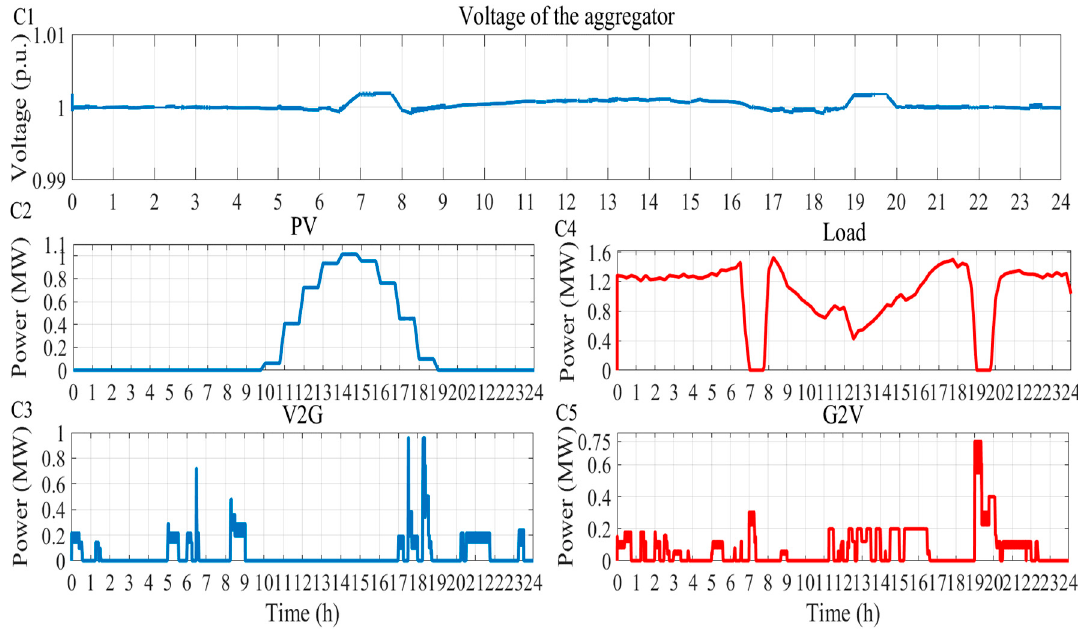
Figure 12. Time-based active power and voltage profile through the architecture (Scenario B): ( C1 ) voltage profile of the aggregator, ( C2 ) generated active power from PV, ( C3 ) injected active power from the aggregator (V2G), ( C4 ) Demand side, ( C5 ) the drawn active power from the architecture to the aggregator (G2V).